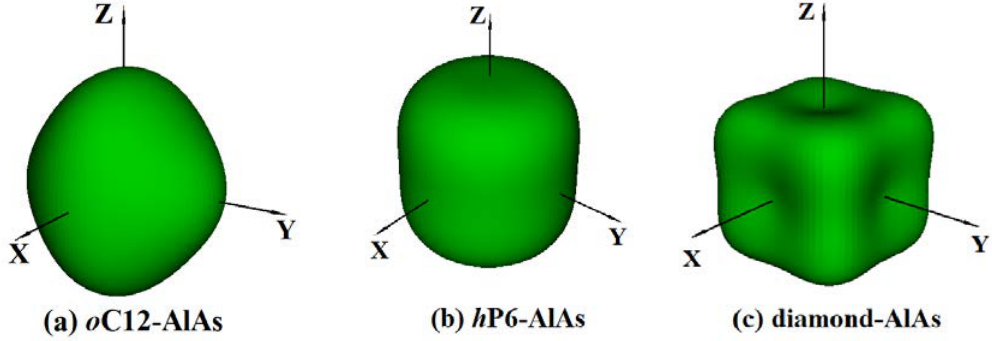
Figure 4. The three-dimensional (3D) surface constructions of Young’s modulus E for o C12-AlAs, h P6-AlAs, and diamond-AlAs at ambient pressure.